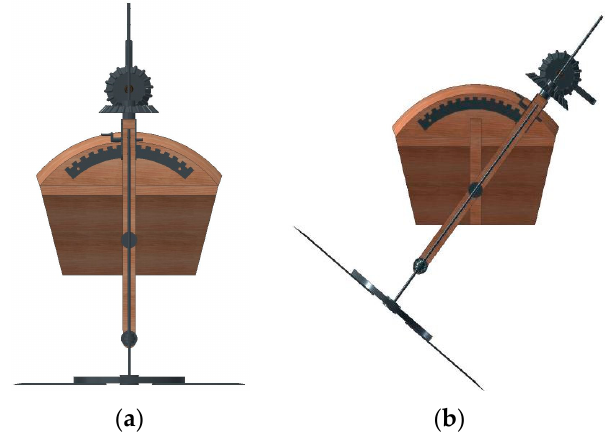
Figure 4. Extreme positions of the vertical mobile frame. ( a ) horizontal cutting plane; ( b ) inclined cutting plane.